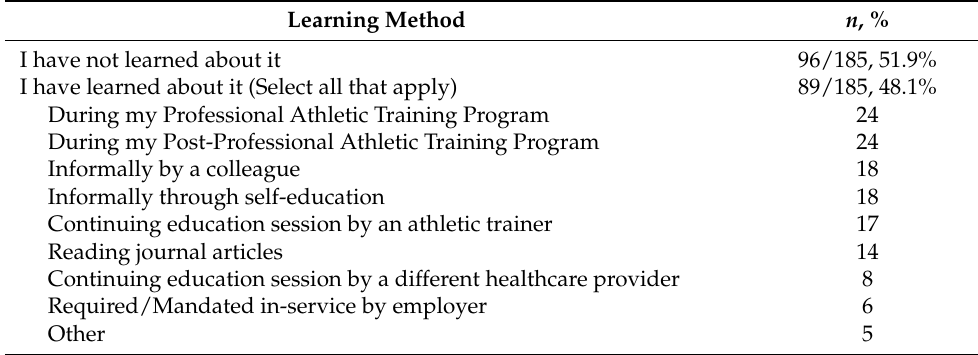
Table 2. Participant educational experiences related to the ICF